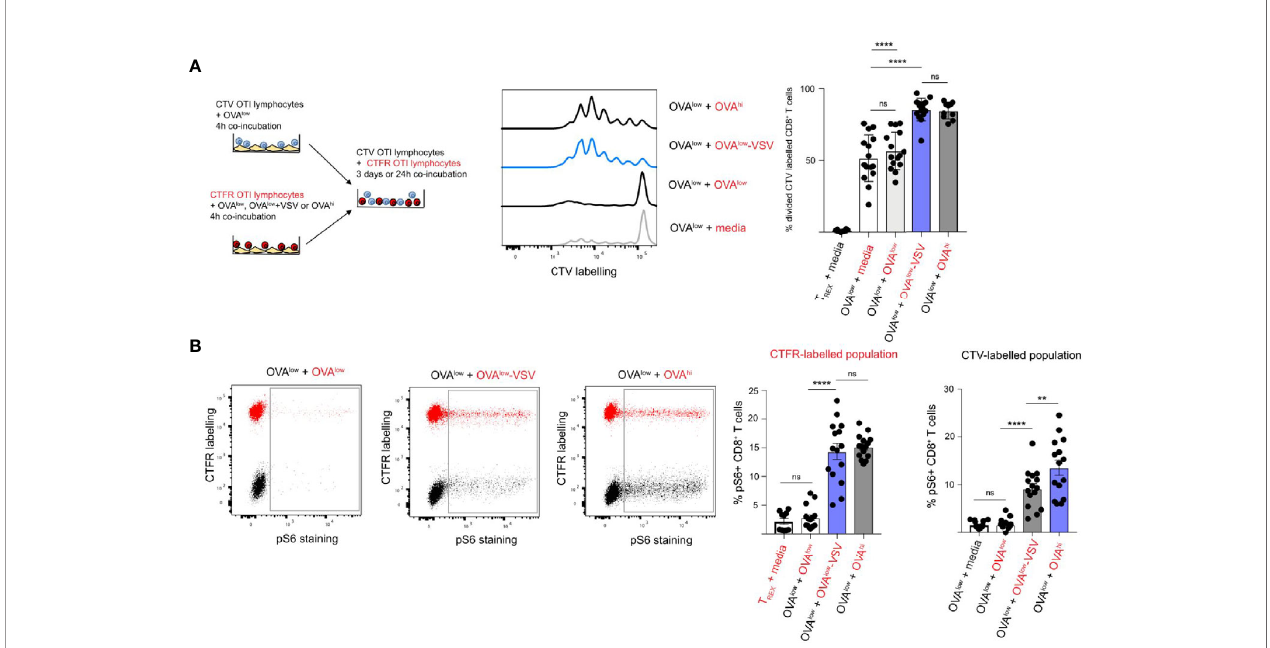
FIGURE 3 | Co-agonism enhances CD8 + T cell quorum responses. (A) CTV or CTFR labelled OT-I lymphocytes were separately stimulated with the indicated CHO APCs for 4h, followed by co-culture of the differentially labelled population for 3 days in the absence of APCs. The representative fl ow cytometry plots show proliferative dye dilution in CTV-labelled CD8 + T cells primed with OVA low APCs co-cultured with CTFR-labelled OT-I cells primed with the indicated CHO APCs (indicated in red). Data from 15 mice from 3 independent experiments. (B) CTV or CTFR labelled OT-I lymphocytes were separately stimulated with the indicated CHO APCs for 4h, followed by co-culture of the differentially labelled population for 20h in the absence of APCs. S6 phosphorylation on CD8 + T cells was assessed using intracellular staining. The representative fl ow cytometry plots show pS6 in co-cultured CTFR-labelled (CTFR + population, indicated in red) and CTV-labelled (CTFR – population, indicated in black) CD8 + T cells primed with the indicated APCs. The graphs show % of pS6 + CD8 + T cells from CTFR and CTV-labelled population, with the priming conditions for CTFR-labelled population indicated in red, and the priming conditions for CTV-labelled population in black. Data from 15 mice from 3 independent experiments. Statistical signi fi cance was calculated using one-way ANOVA, with Tukey ’ s multiple comparisons test. **P < 0.01, ****P < 0.0001, ns, P ≥